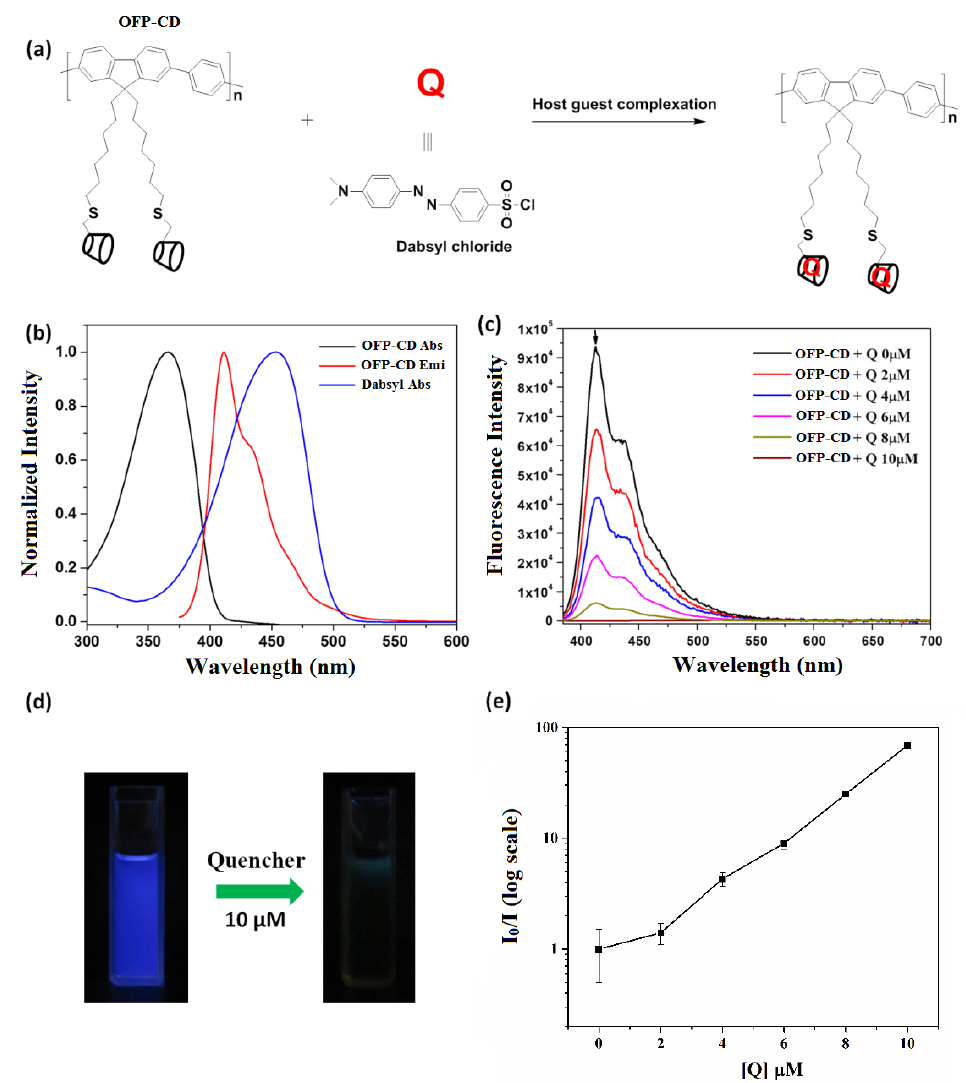
Figure 3. Fluorescence quenching of the host-guest complexation of dabsyl chloride with OFP-CD. ( a ) Schematic representation of the host-guest complexation between OFP-CD and dabsyl chloride; ( b ) Absorption and emission spectra of OFP-CD, along with the absorption spectrum of the quencher dabsyl chloride; ( c ) Fluorescence spectra of OFP-CD (1 µ M) with different concentrations of quencher dabsyl chloride from 0–10 µ M; ( d ) Emission color of OFP-CD (1 µ M) solution observed under a hand-held UV lamp, before and after addition of quencher (10 µ M); ( e ) Stern–Volmer quenching plot for emission spectra of OFP-CD in the presence of dabsyl chloride from 0–10 µ